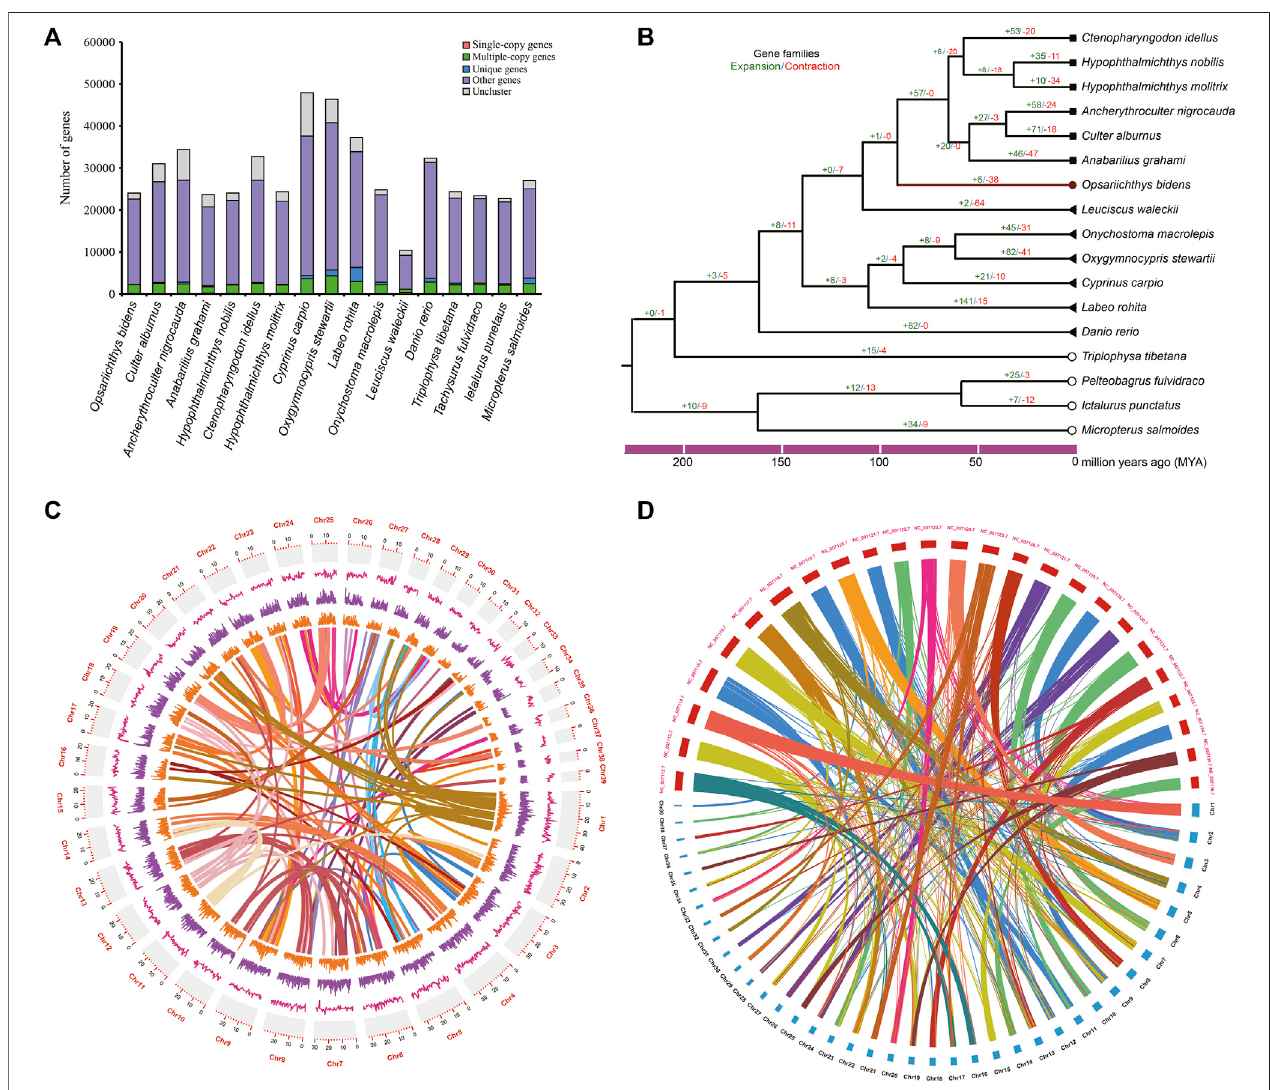
FIGURE 2 | Comparative genome analyses. (A) the number of orthologous for 17 fi sh species and (B) the phylogenetic tree of 17 fi sh species; gene family expansionsandcontractionsareindicatedingreenandred,respectively. (C) Syntenydistributionofthe39chromosomesof O.bidens ;Thetracksindicatethedensityof gene numbers and GC contents, respectively. (D) Comparative synteny analysis between O. bidens and Zebra fi sh.